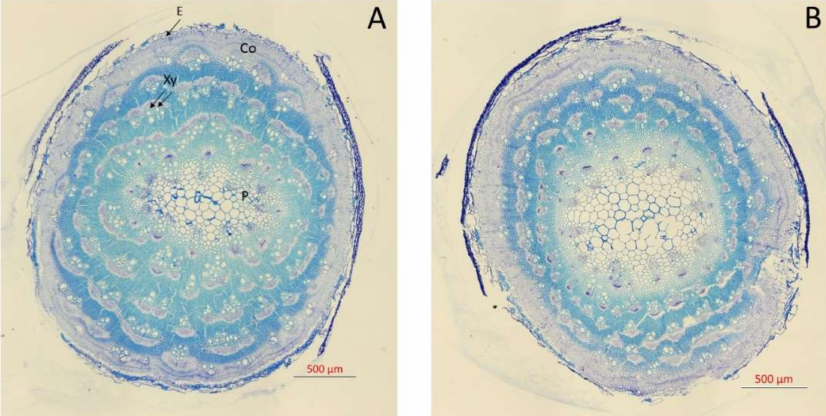
Figure 1. Transversal sections of the main stem of Atriplex halimus L. stained with 1% toluidine blue grown at 171 ( A ) and 513 ( B ) mM NaCl after 60 d treatment showing E (epidermis), Co (cortex), Xy (xylem vessels), and P (pith